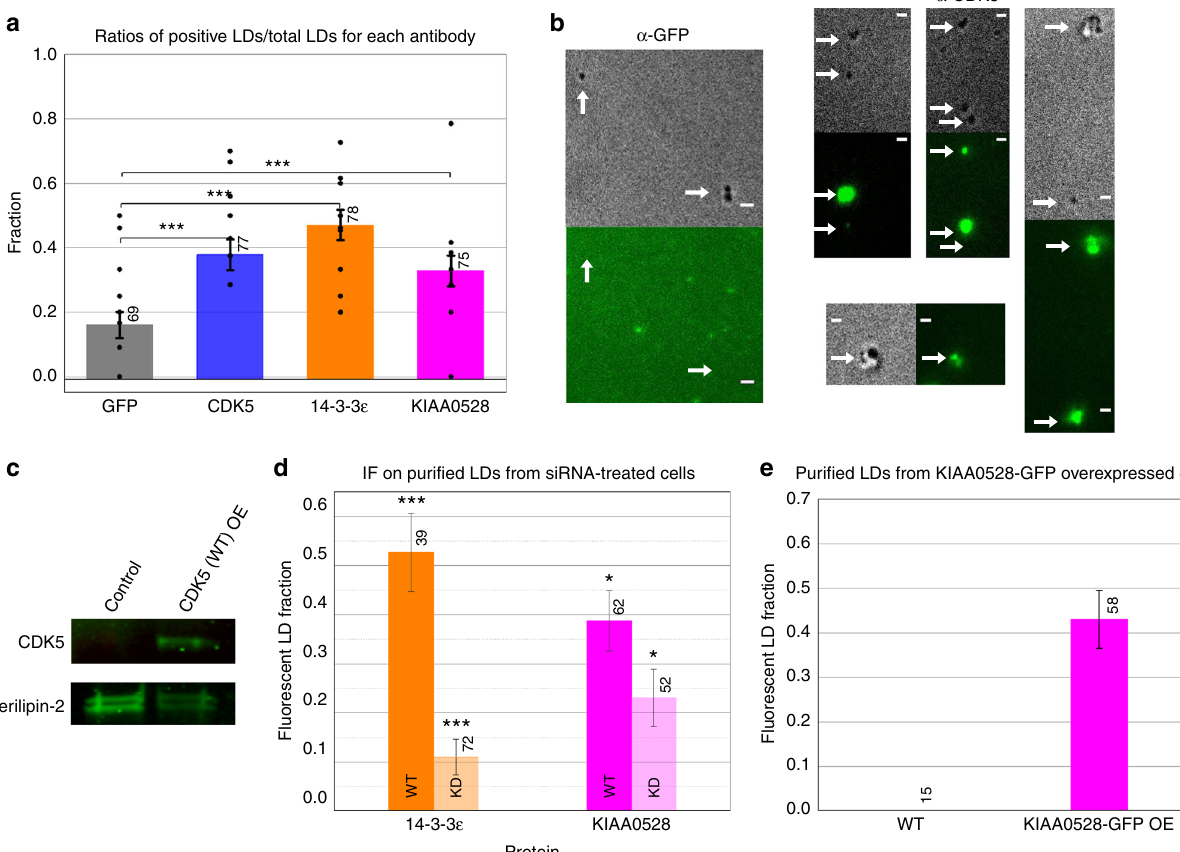
Fig. 3 CDK5 and 14-3-3 ε and KIAA0528 are found on lipid droplet (LD) cargo. Intact puri fi ed LDs were probed with antibodies against CDK5, 14-3-3 ε , KIAA0528, and GFP (negative control), the percentage of LDs that had detectable immuno fl uorescence signal quanti fi cation is shown in a and sample immuno fl uorescence images are shown in b with 2 μ m scale bars, and white arrows designate lipid droplets. To assess CDK5 localization to LDs, proteins were precipitated from puri fi ed LDs and analyzed by WB. Perilipin-2: (an LD marker) is present on both samples and 25× CDK5 is present on the LDs from the CDK5 overexpression background ( c ). To assess 14-3-3 ε and KIAA0528 localization, IF experiments were performed on LDs puri fi ed from wild-type or siRNA-treated cells. LDs from the KD cells showed reduced levels of the respective proteins, quanti fi ed in d , with example images for each experiment in the supplement, Fig. 6. To further con fi rm KIAA0528 LD localization, LDs were puri fi ed from wild-type (WT) or KIAA0528-GFP overexpressing cells, and the percentage of LDs with GFP puncta was quanti fi ed. LDs from KIAA0528-GFP cells show increased puncta compared to WT cells ( e ). Representative fl uorescence images are in the supplement, Fig. 6. Quanti fi ed data represent the mean ± s.e.m. of n = 2 independent experiments. Two-sided test of proportions P values * P < 0.05, *** P < 0.001, **** P <